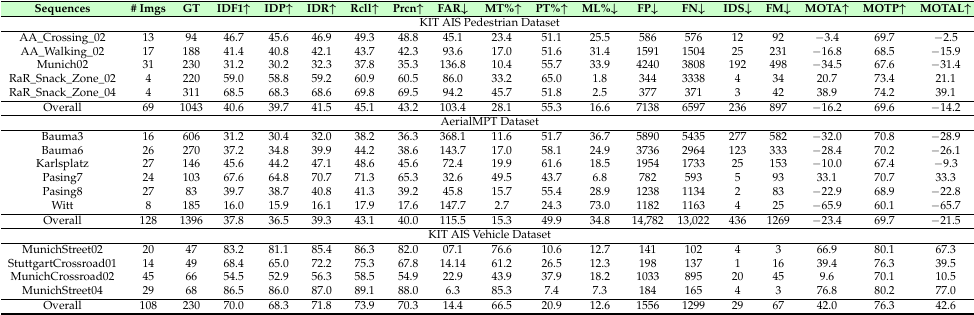
Table 14. AerialMPTNet on the KIT AIS and AerialMPT datasets.